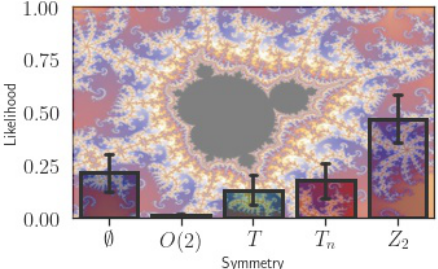
Figure 8: Representation of a Mandelbrot set and the algorithm